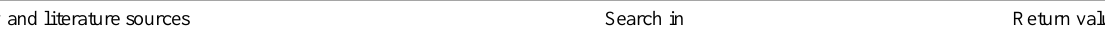
Table 1. Literature sources and keywords.